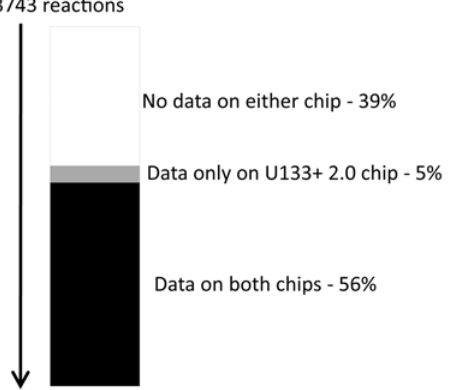
Figure 9. The mapping of Affymetrix gene chip data to reactions. Reactions in the white area have no usable gene chip data on either platform. Reactions in grey have usable data only on the 133 + 2.0 platform. Reactions in black have usable data for both the 133 + 2.0 and the 133A platform. Importantly, 5% (179) of the reactions are only represented on the 133 + 2.0 chip, potentially increasing scores across chips. The average difference score is 340, so a difference of 179 reactions is greater than a 50% impact.